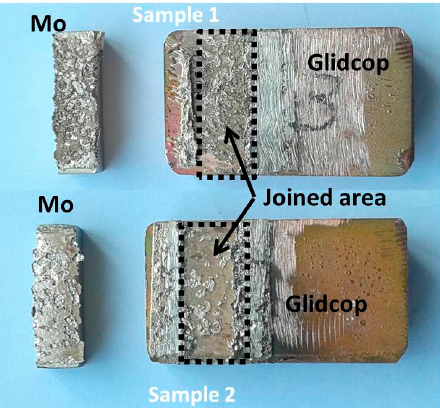
Figure 9. Fracture surface of Mo/Glidcop brazed samples after apparent shear test according to ASTM B898-11.